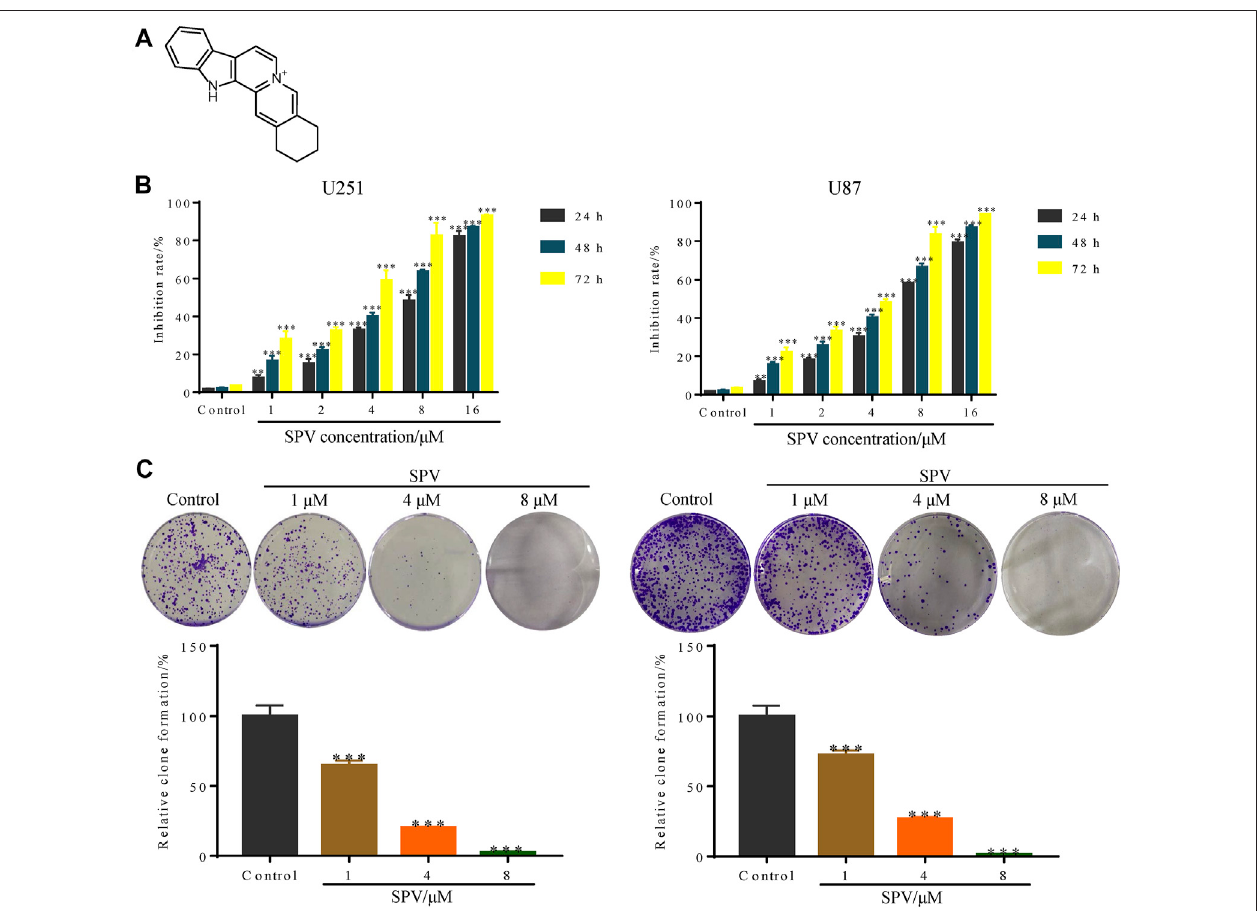
Figure 1 | Sempervirine (SPV) inhibited cell viability in glioma cells. (A) The molecular structure of sempervirine. (B) Two glioma cell lines (U251, U87) were treated withsempervirine (0, 1,2,4, 8and16 μ M) for24, 48and72 h.Cell viabilitywasmeasured byMTTassay. (C) U251and U87cells weretreated withsempervirine (0, 1,4 and8 μ M)for48 h,andthenwereuntreatedforapproximately14days.Cellcolonyformationwasassessed.DataarepresentedastheMean ± SD ( n (cid:2) 3).** p < 0.01and *** p < 0.001 compared with the control group.